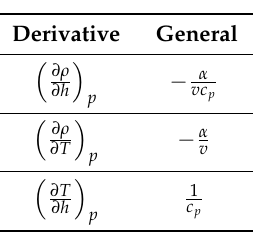
Table A1. Constant Pressure.